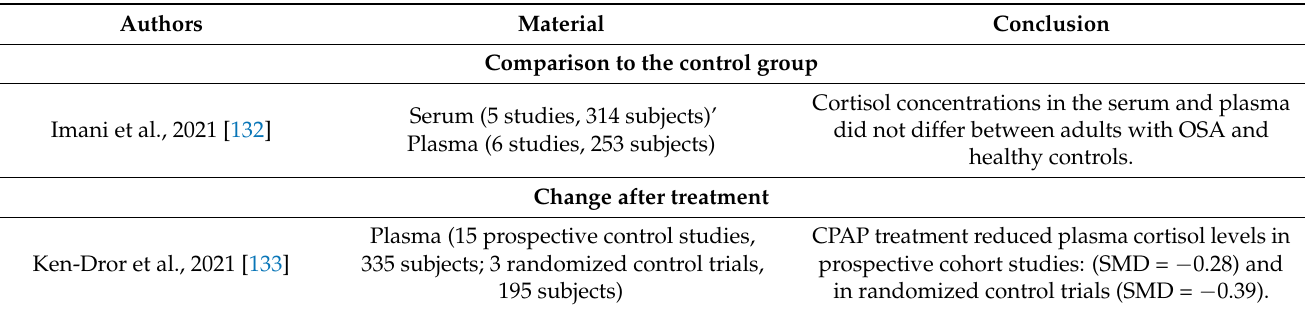
Table 16. Meta-analyses of cortisol